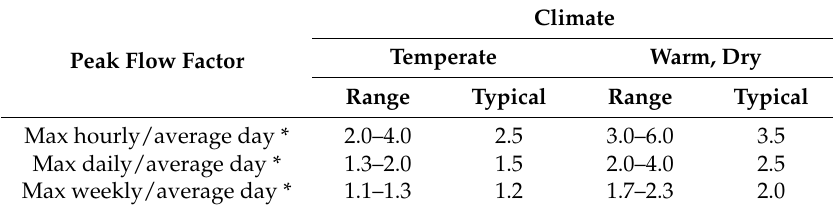
Table 1. Peak flow factors computed at different time scales [9].